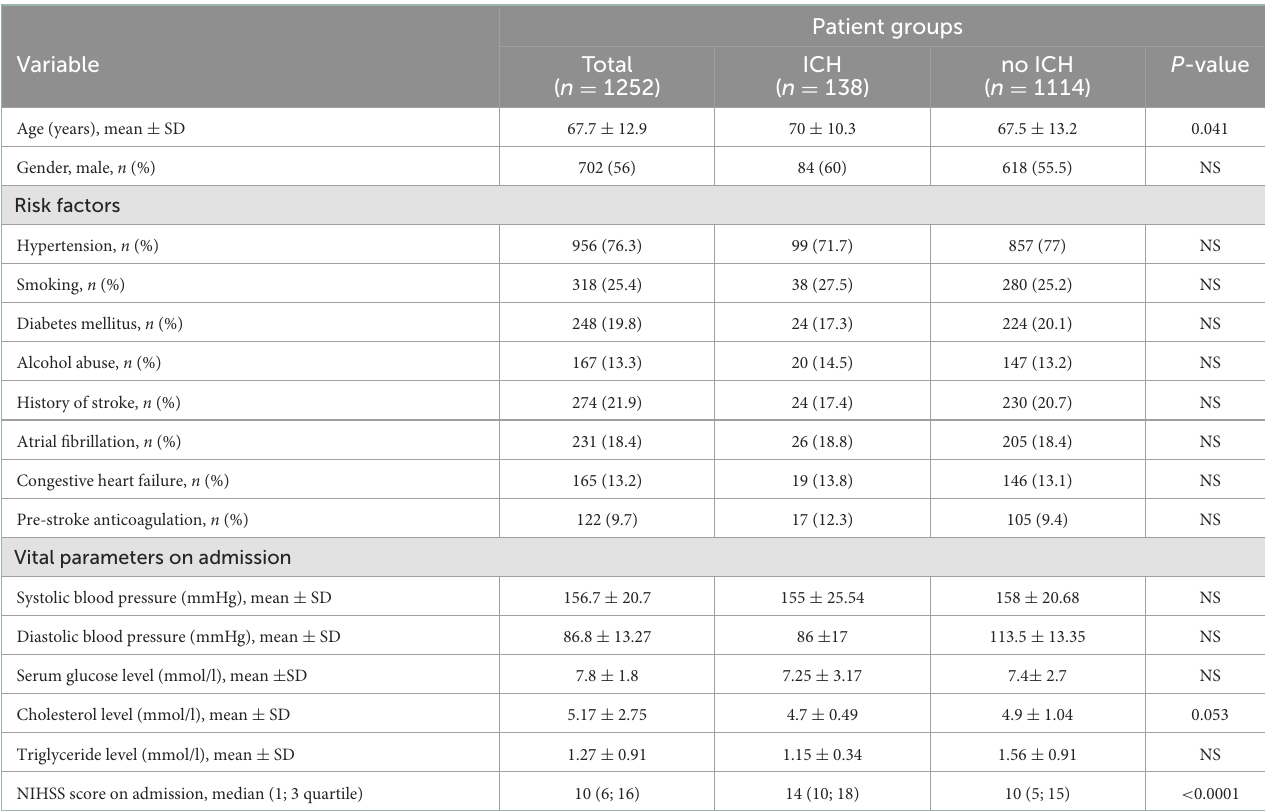
TABLE 1 Baseline characteristics, risk factors, and clinical parameters of